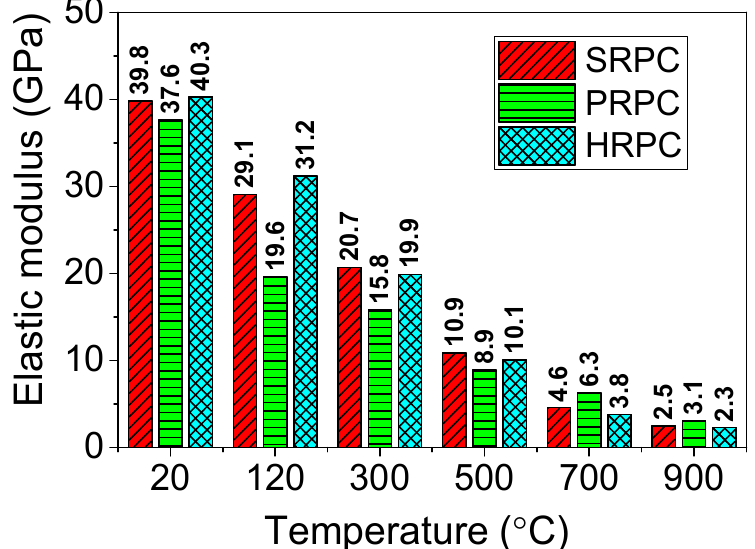
Figure 8. Elastic modulus of RPC as a function of temperature.